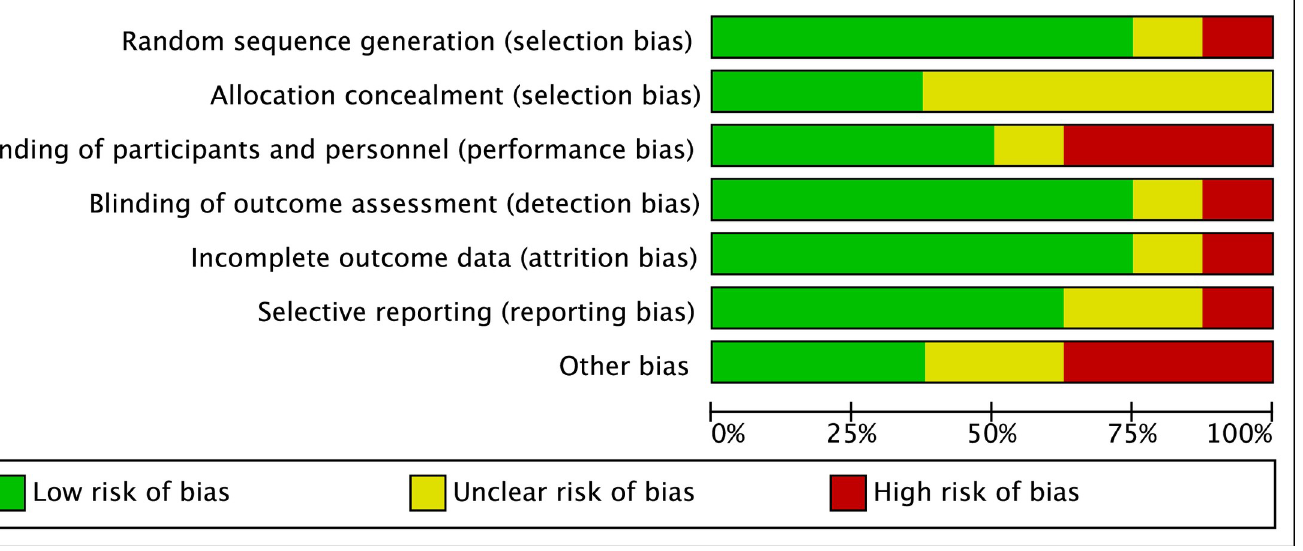
Fig 2. Quality assessment of selected